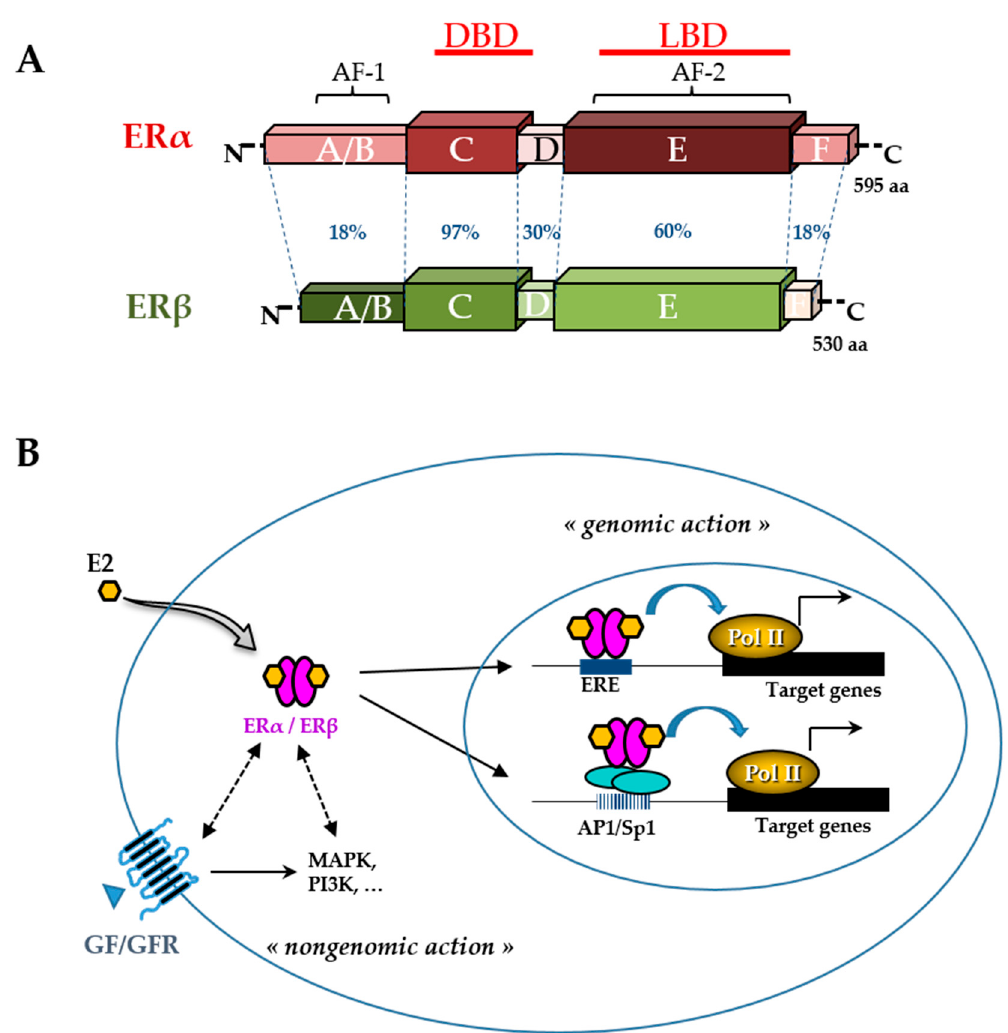
Figure 3. Estrogen receptor (ER) structure and action. The schematic structures of the two human ER α and ER β and the percentage of homology between the different domains (annotated by the letters A to F) are indicated ( A ). Domains involved in DNA binding (DBD), ligand binding (LBD), ligand-independent transactivation function 1 (AF-1), and ligand-dependent transactivation function 2 (AF-2) are shown. The number of amino acids for each receptor is also indicated on the right side. Estradiol (E2) mediates numerous phenotypic effects in cells by binding to and activating ERs ( B ). E2 enters the cell through the lipid membranes and binds ER, which can be present in the cytoplasm and the nucleus. The activated ER forms a dimer to tightly fix chromatin directly at the estrogen-responsive element (ERE) sites or indirectly at activator protein 1 (AP1) or specificity protein 1 (Sp1) sites. ER is then able to remodel chromatin by recruiting cofactors and activating RNA polymerase II (Pol II), at target genes (genomic action). Besides, ERs can use rapid non-genomic action through the interaction with intracellular kinases (mitogen-activated protein kinase (MAPK), phosphatidylinositol 3-kinase (PI3K),…) and the growth factor (GF) receptor (GFR) pathways.